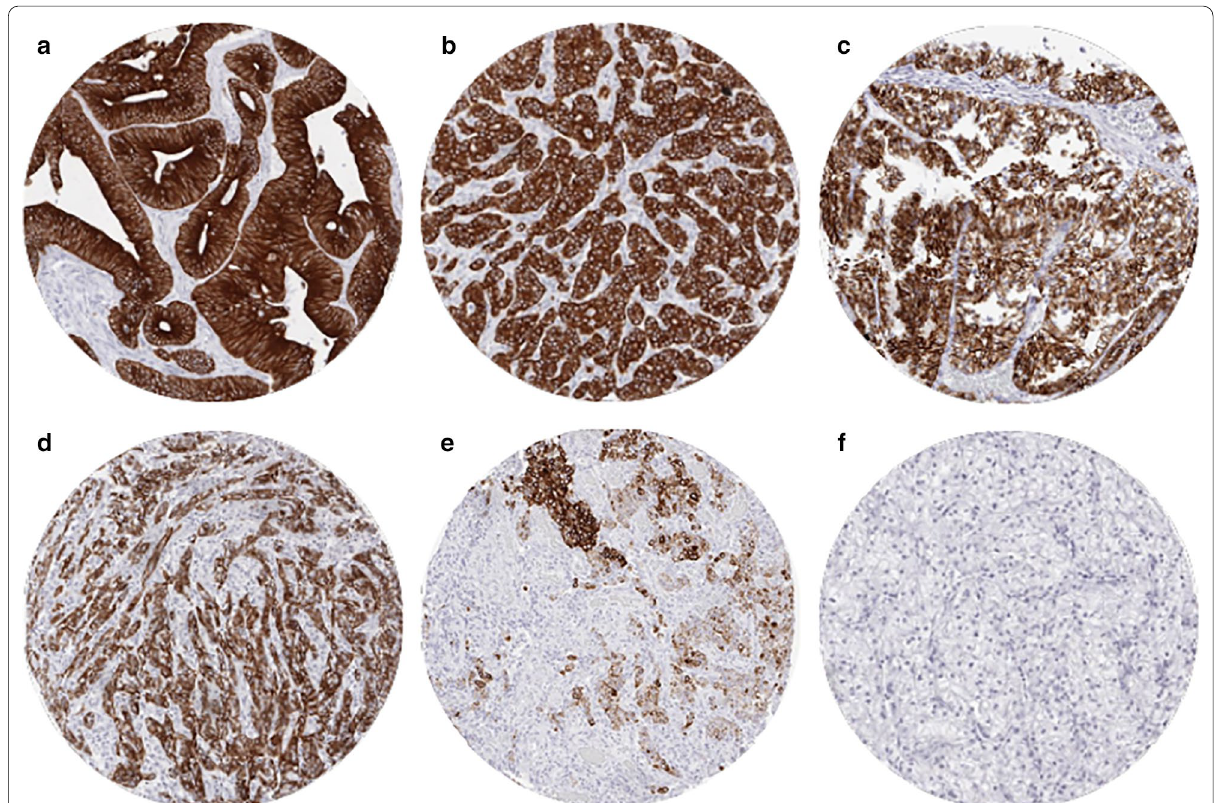
Fig. 2 Cytokeratin 18 (CK18) expression in tumors. The images show diffuse strong CK18 staining in a colorectal carcinoma ( a ), an invasive breast carcinoma of no special type ( b ), a clear cell carcinoma of the kidney ( c ), and a squamous cell carcinoma of the cervix uteri ( d ). CK18 immunostaining is focal in a squamous cell carcinoma of the larynx ( e ) and absent in another renal cell clear cell carcinoma ( f